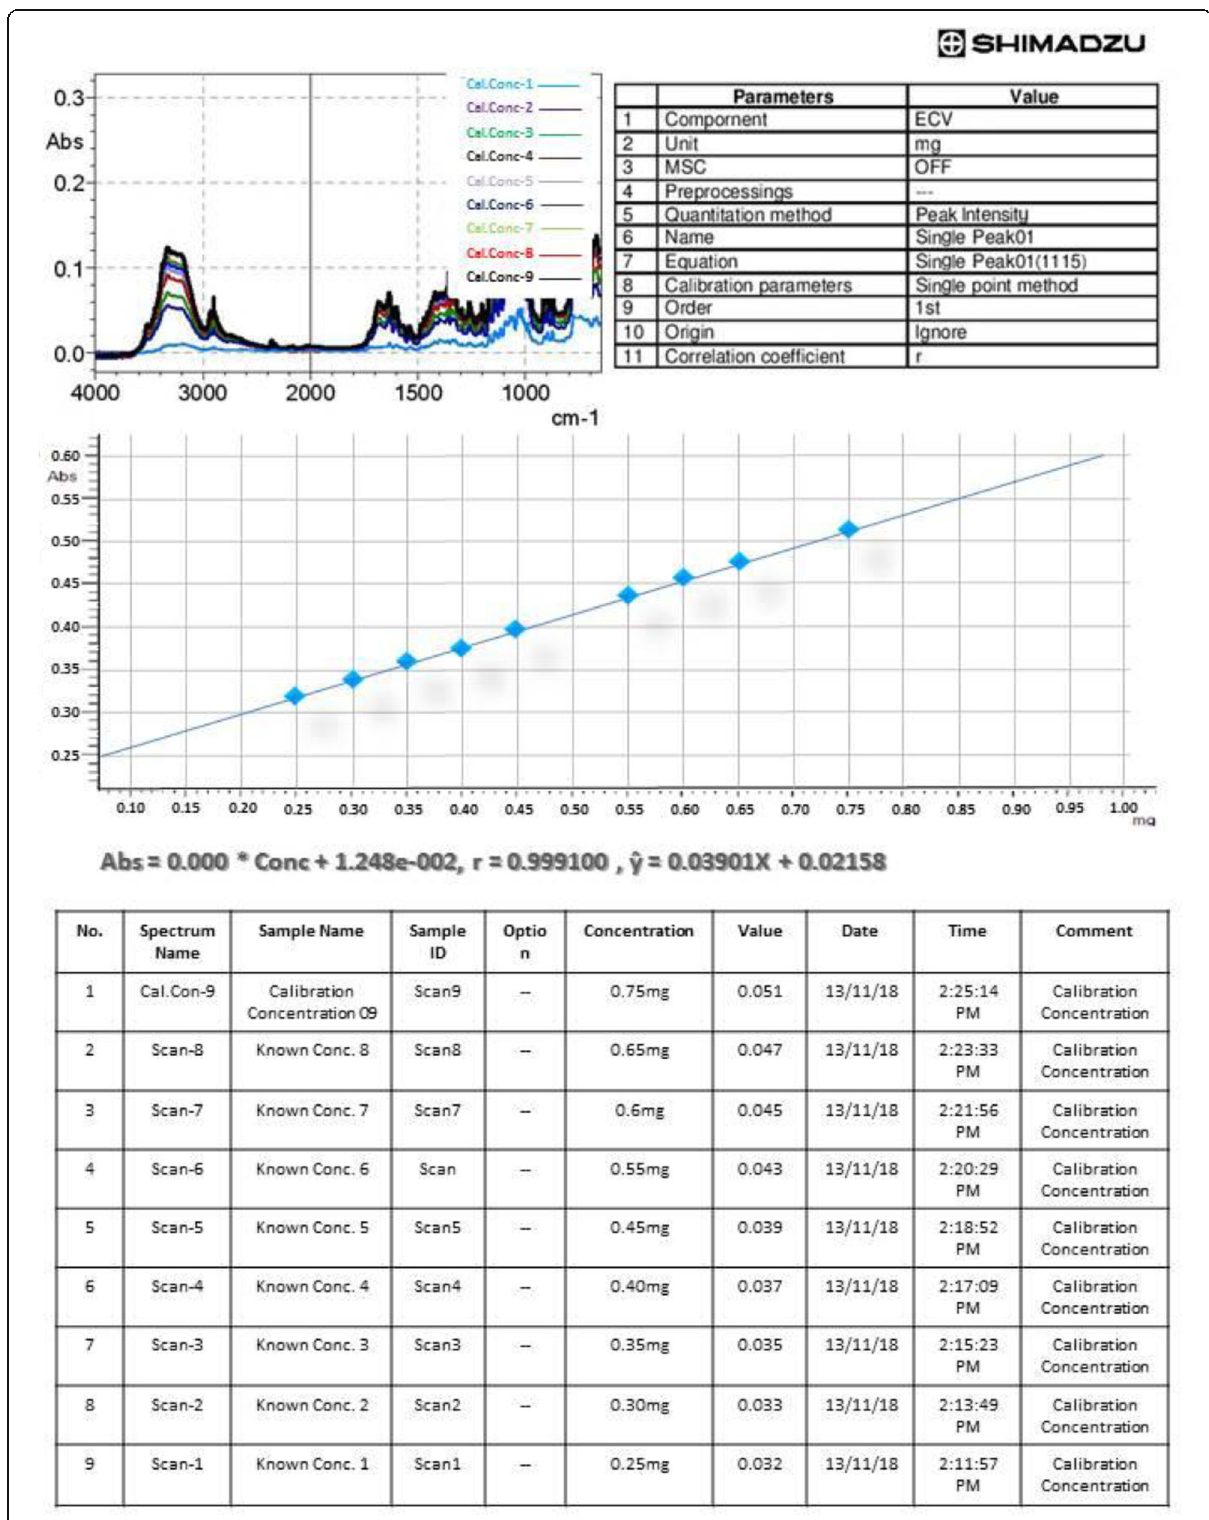
Fig. 4 The overlay scan of all nine concentrations and calibration curve of